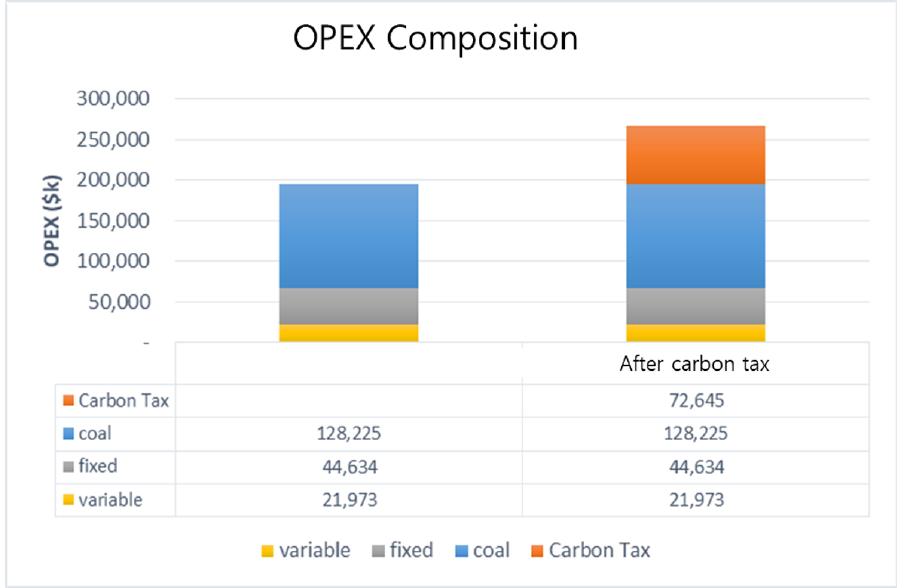
Figure 10. Comparison of OPEX composition with carbon cost.